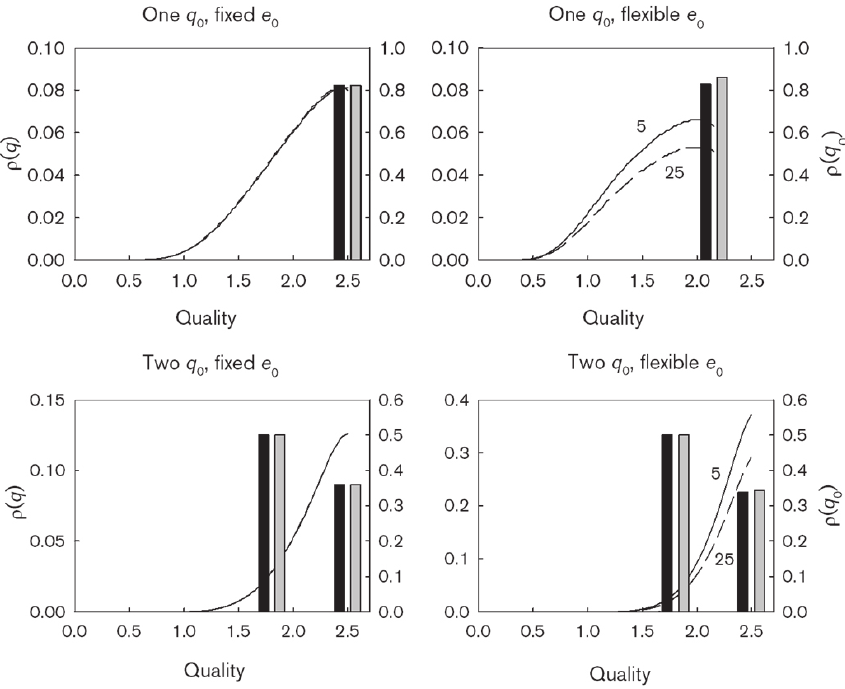
Fig. 6. Distributions of qualities for combinations of one or two initial qualities and fixed or flexible decomposer efficiency ( e 0 ) when 12% carbon has been lost for samples incubated at 5 ◦ C or 25 ◦ C. Solid lines and black bars are for samples at 5 ◦ C. Dashed lines and grey bars are for samples at 25 ◦ C. The bars have been shifted slightly leftwards and rightwards from their value to visually separate them. Bars show the amount of carbon that has not been used by decomposers so far (remaining at the initial qualities). The lines show the distributions of carbon that the decomposers have converted into new qualities. With flexible decomposer efficiency, more carbon has been converted (lines) and less remains at the initial quality (bar) at the higher temperature. With two initial qualities the losses have essentially only occurred from the highest quality. Note that the sums of the bar(s) and the areas under the corresponding temperature curves are all equal, 88% of initial